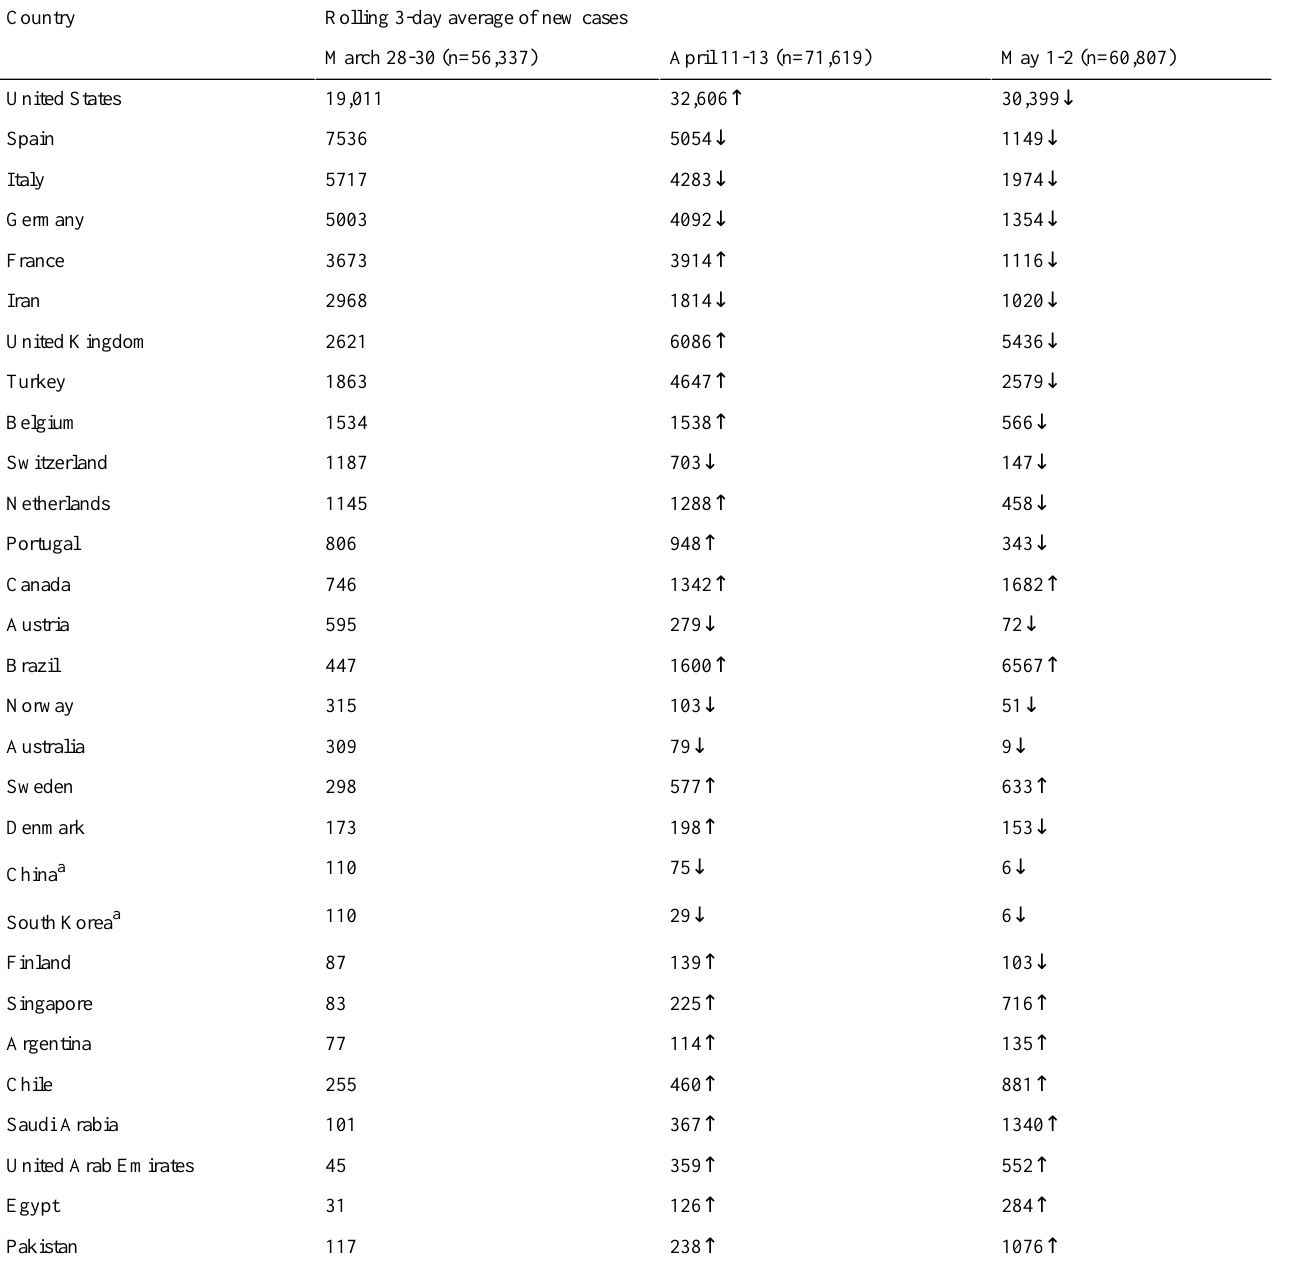
Table 1. Rolling 3-day average of daily new confirmed cases of COVID-19 among selected countries from March 28-30, April 11-13, and May 1-2, 2020. Source: Our World in Data